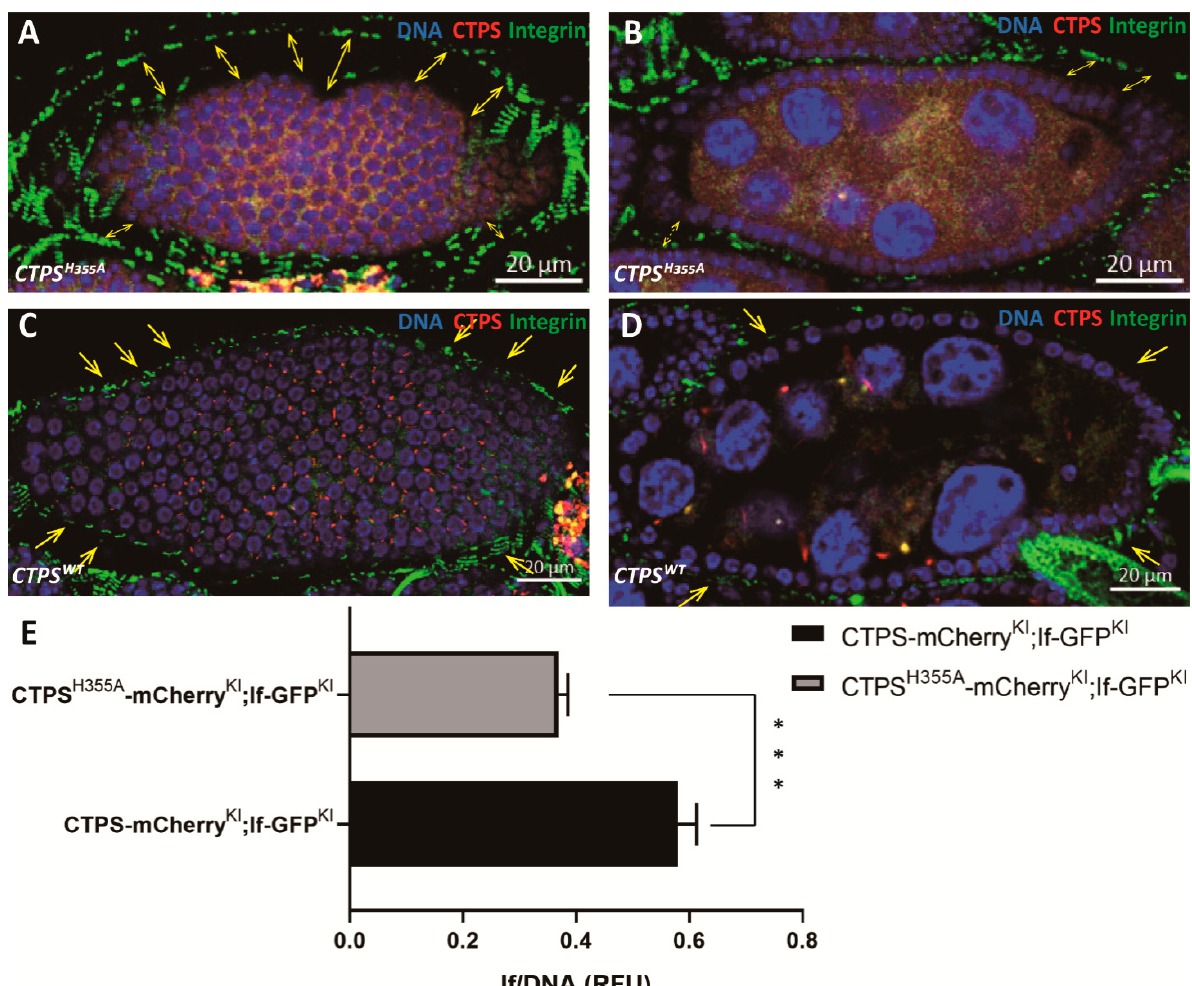
Figure 12. Compared with wild-type control, the space increases between muscle sheath and egg chambers in CTPS H355A . ( A , B ) A stage 8 egg chamber of the CTPS H355A mutant. Integrin is labeled with knock-in GFP (green). CTPS H355A is labeled with knock-in mCherry (red). Yellow arrows point to gap between egg chamber and the muscle sheath. ( C , D ) A stage 8 wild-type egg chamber. Integrin is labeled by knock-in GFP. CTPS is labeled by knock-in mCherry. Scale bars, 20 μ m. ( E ) The ratio of GFP intensity of the integrin to DNA from A – D . The value is normalized to the control (5 im- ages/genotypes, 3 biological replicates). Mann-Whitney U test. ***, p = 0.0005.